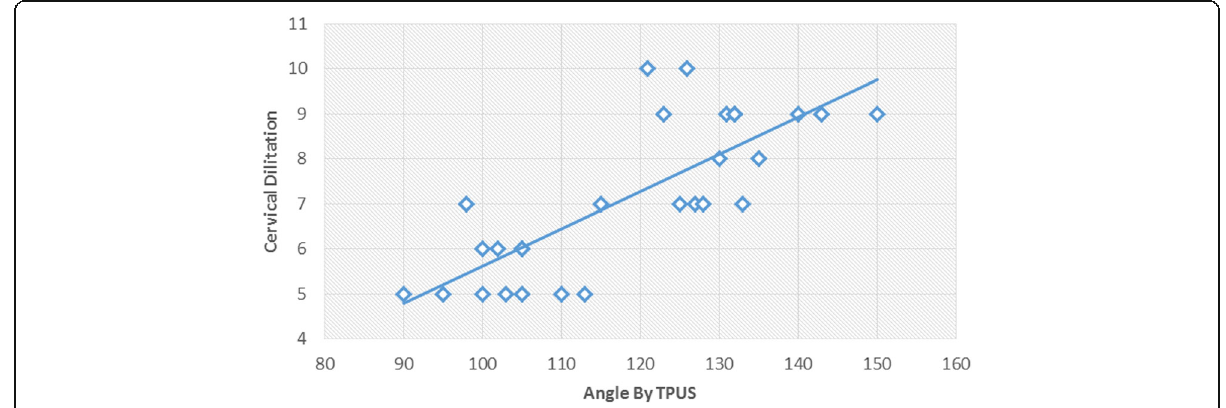
Fig. 6 Correlation between cervical dilatation and angle of fetal head descent